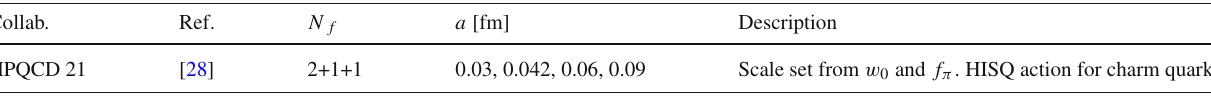
Table 95 Continuum extrapolations/estimation of lattice artifacts in the determinations of m b with N f = 2 + 1 + 1 quark flavours Collab.